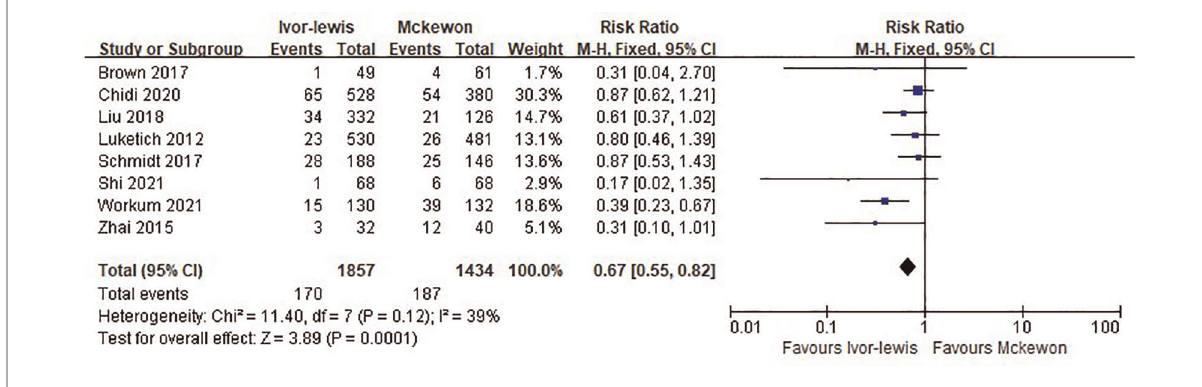
Table 2 . Five studies evaluated grade ≥ 2 anastomotic leak, and there was no signi fi cant difference between the Ivor Lewis and McKeown procedure (RR = 0.71, 95% CI, 0.46 – 1.10, P = 0.09) ( Figure 3 ).